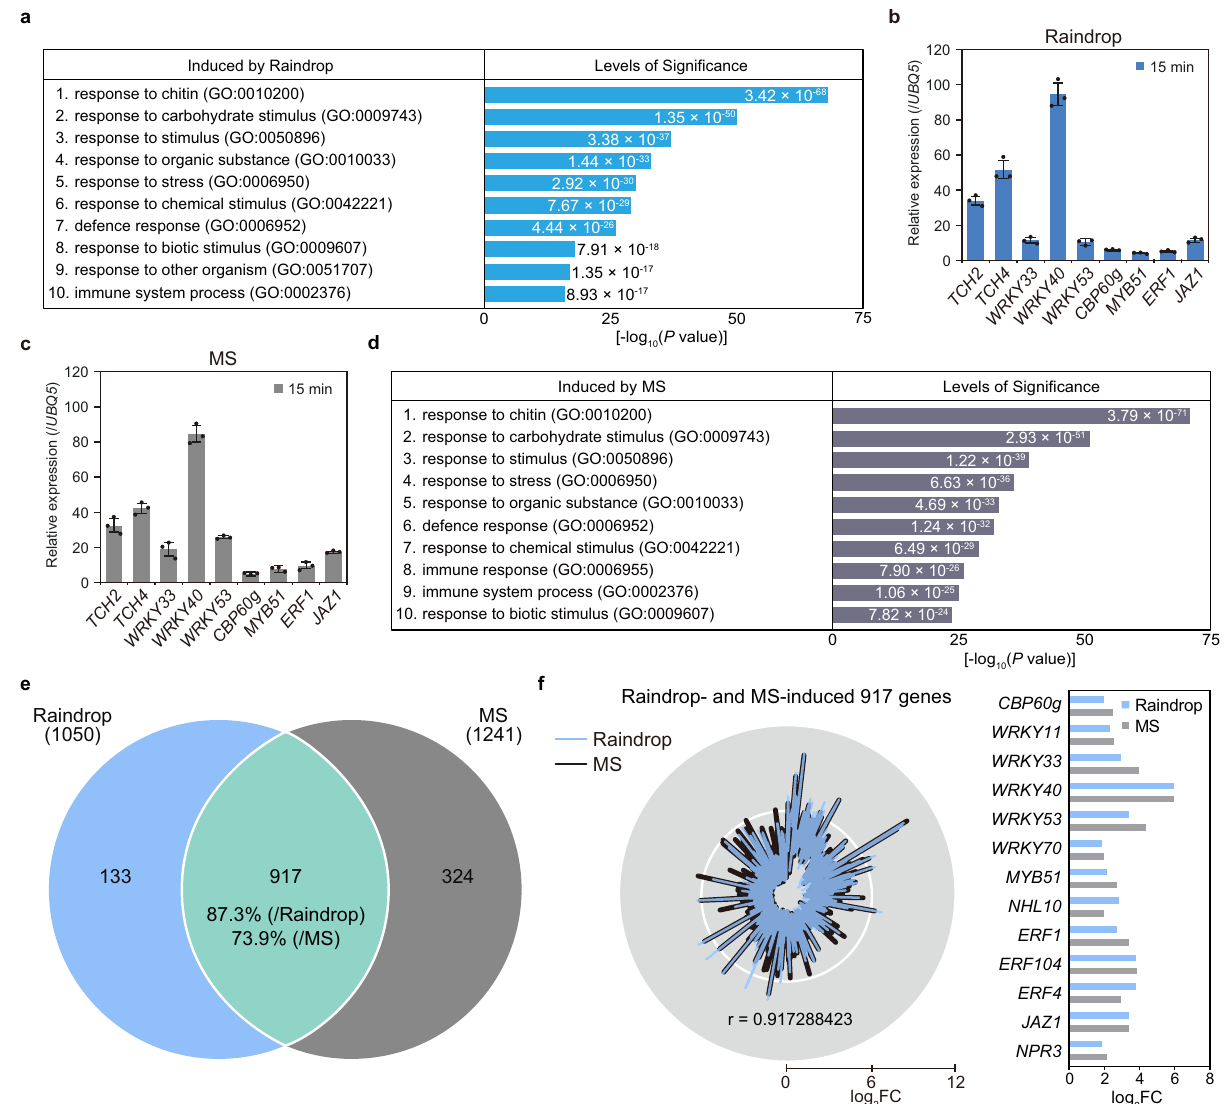
Fig. 1 Raindrop- and mechanical stimuli (MS)-induced transcriptome pro fi les highly correlate with each other. a Enriched Gene Ontology (GO) categories of 1050 raindrop (10 falling droplets)-induced genes in the wild type (Col-0) 15 min after treatment. The top 10 categories are shown in ascending order of P values (one-sided hypergeometric test). b , c Transcript levels of MS-induced and defense-related genes in 4-week-old Col-0 plants 15 min after being treated with 10 falling droplets (raindrop, b ) or 1 brushing (MS, c ), determined by RT-qPCR and normalized to UBIQUITIN 5 ( UBQ5 ). Data are presented as mean ± SD. n = 6 plants examined over three independent experiments. Each dot indicates a technical replicate. d Enriched GO categories of 1241 MS (1 brushing)-induced genes in Col-0 15 min after treatment. The top ten categories are shown in ascending order of P values (one-sided hypergeometric test). e Venn diagram of the overlap between transcriptome datasets from raindrop- and MS-induced genes (likelihood ratio test; P < 0.05). f Radar chart of intensity compared with mock (log 2 FC) and Pearson correlation coef fi cient ( r = 0.917288423) of 917 raindrop- and MS-induced genes (left). Intensities of major immune regulator genes induced by raindrops and MS in RNA-seq analysis (log 2 FC) (likelihood ratio test; P < 0.05)